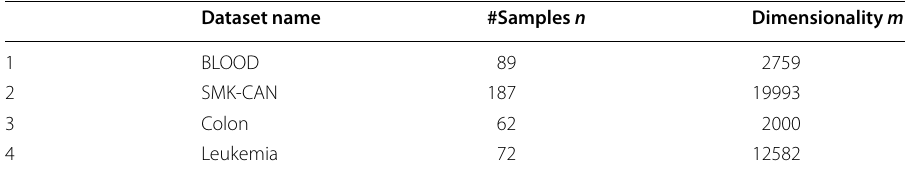
Table 1 Datasets statistics